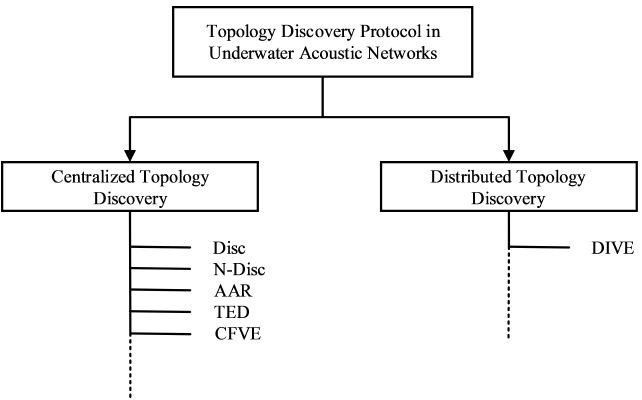
Figure 1. Taxonomy of the existing topology discovery protocols in underwater acoustic networks.